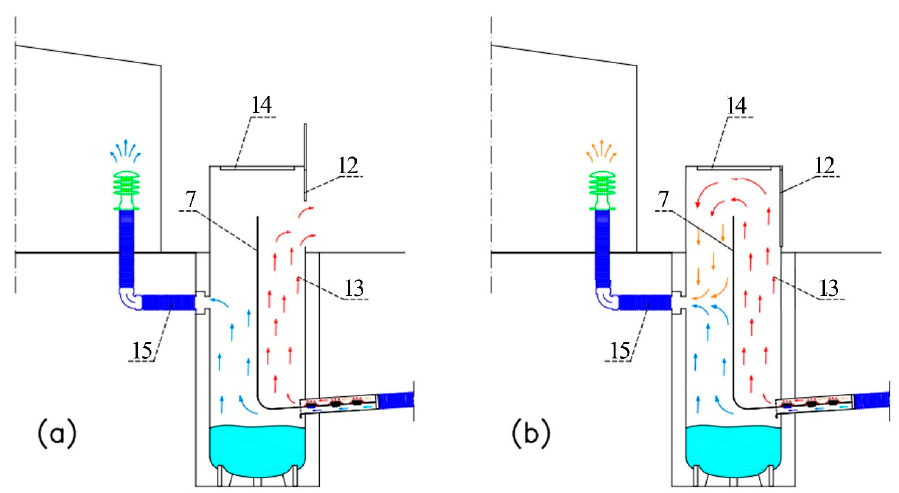
Figure 4. The entire system: open grille ( a ) and closed grille ( b ). Table 1. Labeling used for the description of the components of the system and moist air conditions in Figures 1–4.